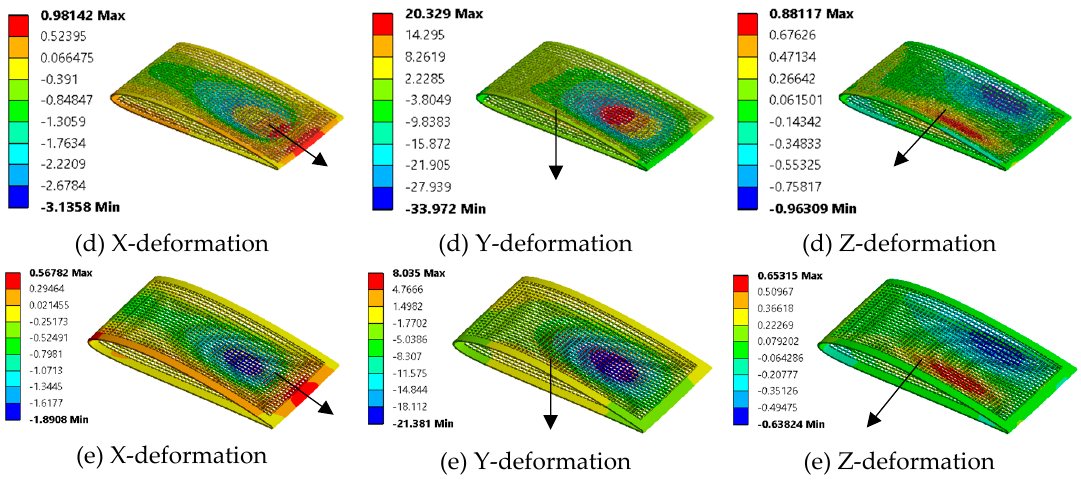
Figure 13. Selected models’ out-of-plane deformation for the linear morphing case: ( a ) honeycomb, ( b ) auxetic, ( c ) chiral, ( d ) zero Poisson’s ratio honeycomb, and ( e ) square lattices. Table 4. Selected models’ directional deformation for the linear morphing